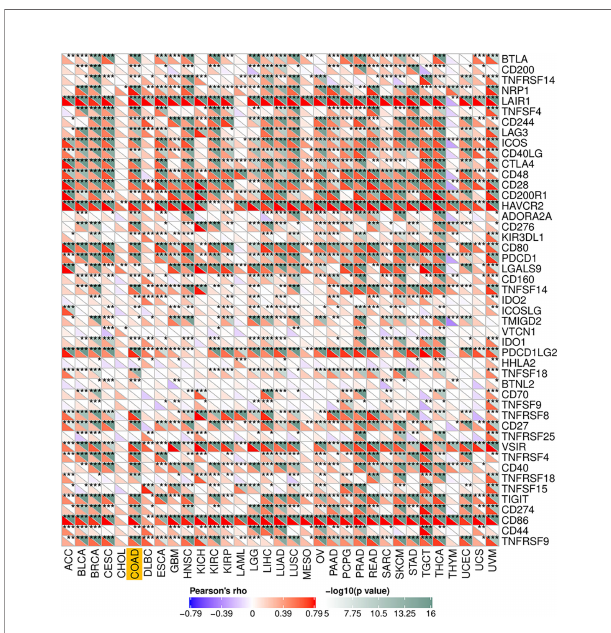
FIGURE 7 | Associations between CSF-1R and immune checkpoint molecules. *P < 0.05, **P < 0.01, ***P <